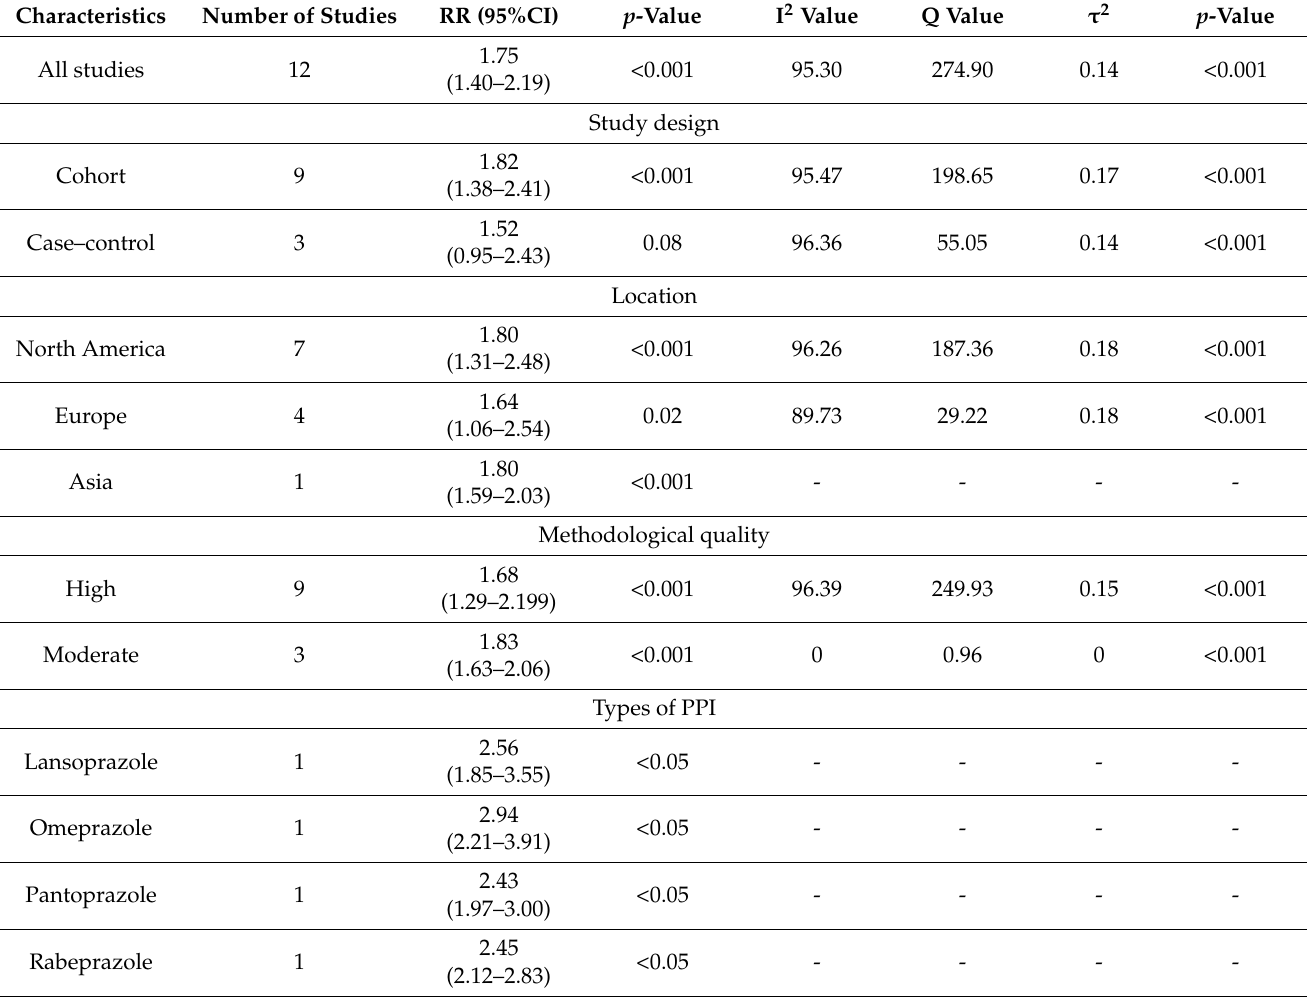
Table 2. Subgroup analysis of the association between PPI use and the risk of acute kidney injury.